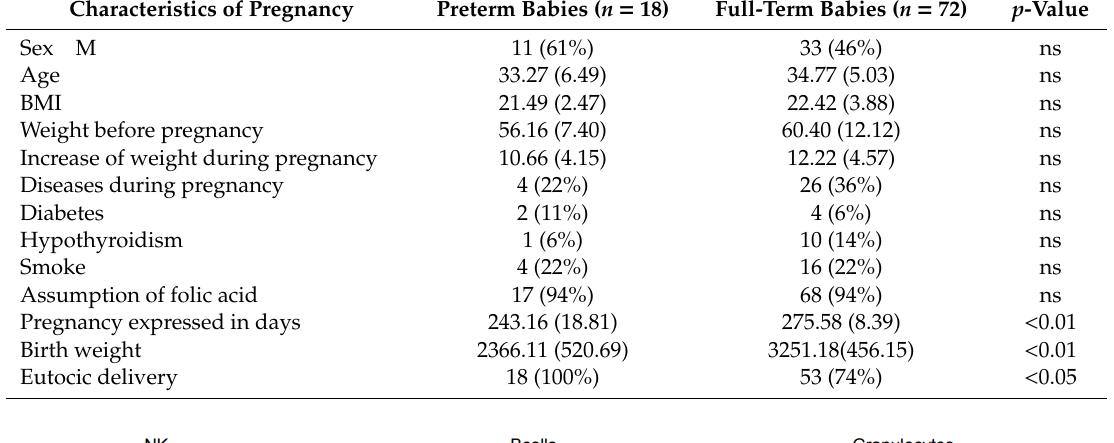
Table 1. Phenotypic characteristics of the 90 subjects recruited: 18 preterm and 72 full-term babies.